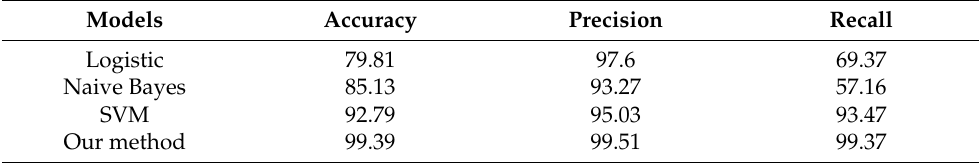
Table 9. The comparison of our model with machine learning methods (%). Models Accuracy